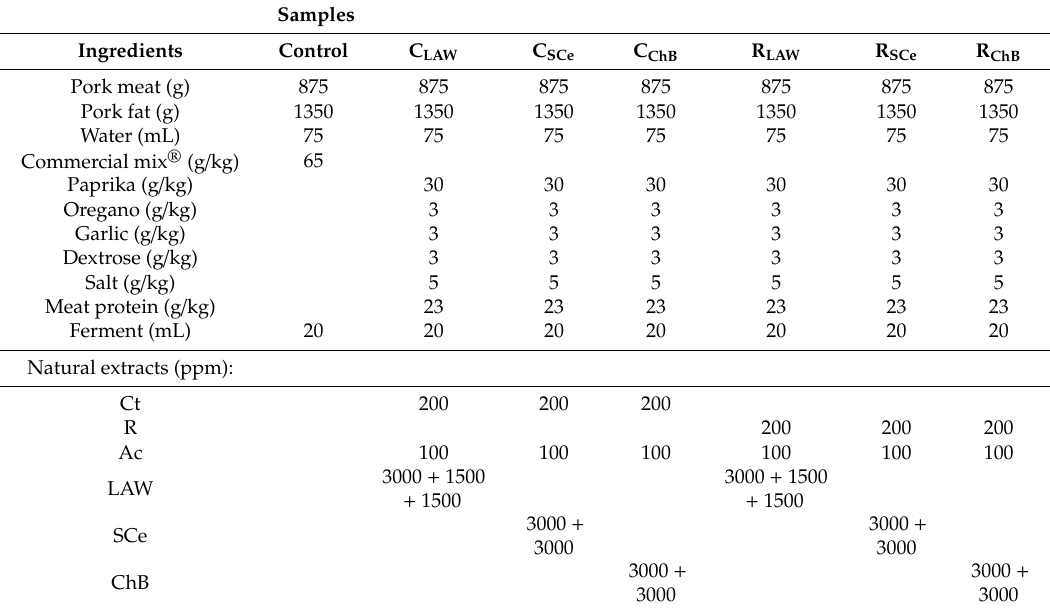
Table 1. Formulation of Spanish chorizo